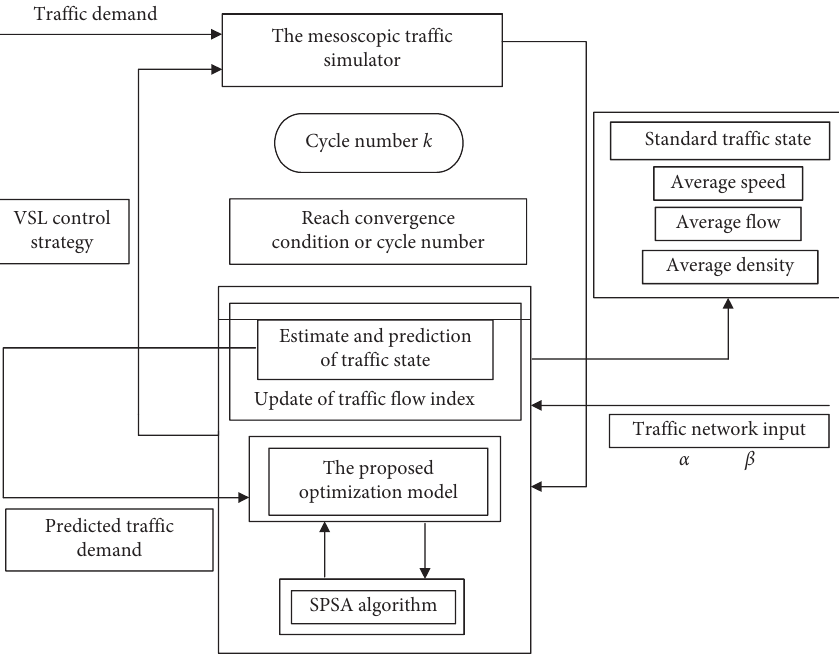
Figure 6: The simulation